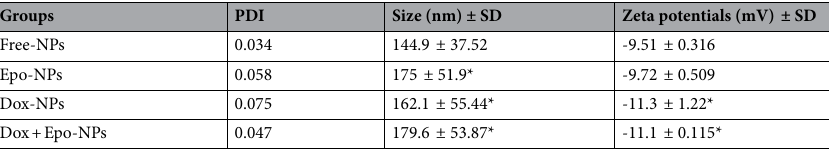
Table 1. Average particle size and zeta potential values of the synthesized NPs. *Values of treatment groups are significantly different from those of free-NPs (p < 0.05).